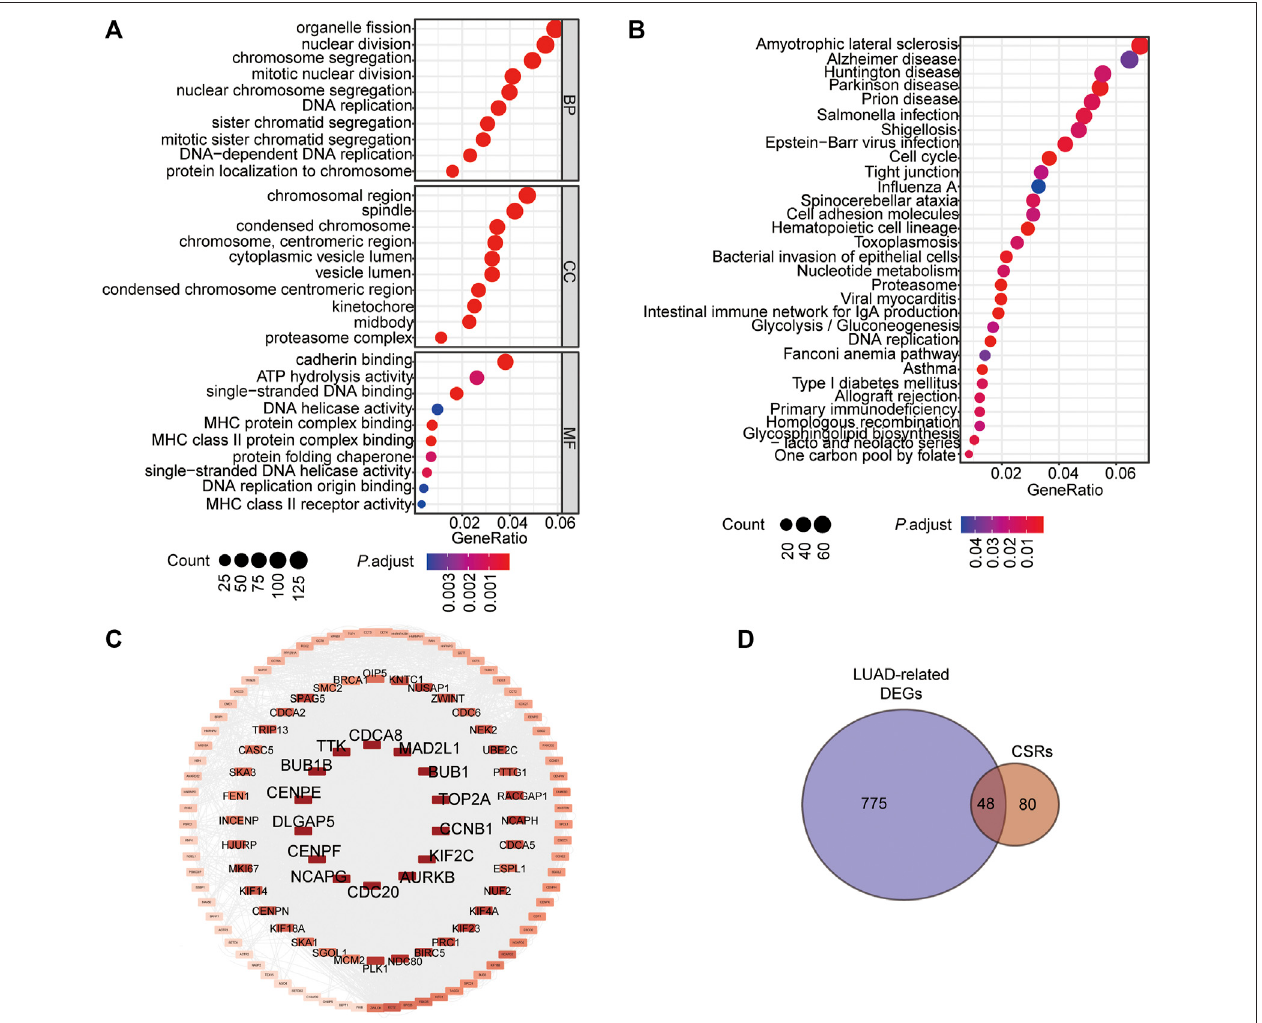
FIGURE 1 | Chromatin Separation is the main bioprocess enriched by the prognostic genes in LUAD. (A) GO enrichment of the prognostic genes in LUAD. (B) KEGG enrichment of the prognostic genes in LUAD. (C) PPI network of the 128 CSRs. (D) Venn drawing showing the co genes between the 128 CSRs and LUAD- related DEGs. The LUAD-related DEGs were genes differentially expressed in LUAD-samples compared to the normal samples. Fold change > 2, P . adjust < 0.05.